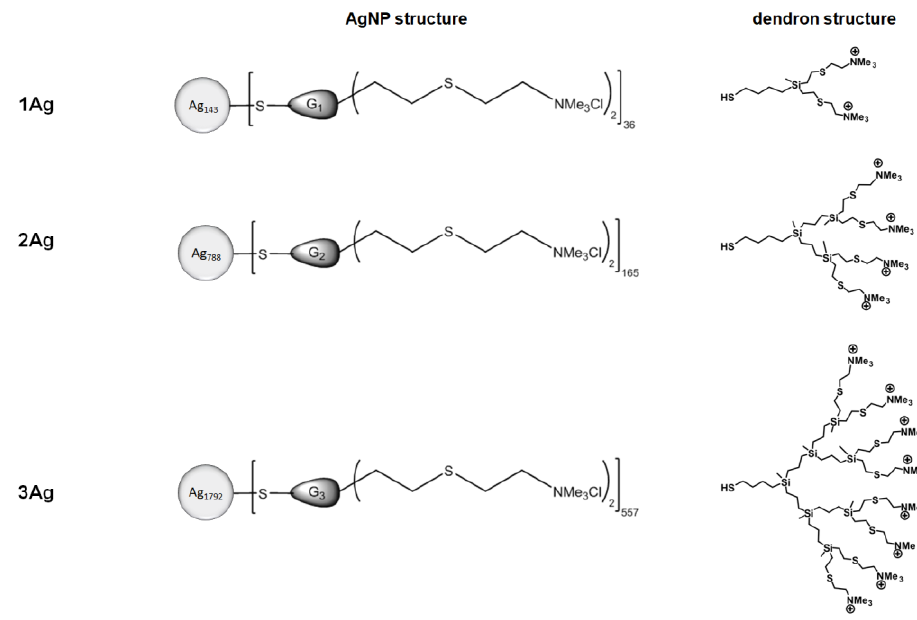
Figure 1. Chemical structures of the studied AgNPs.